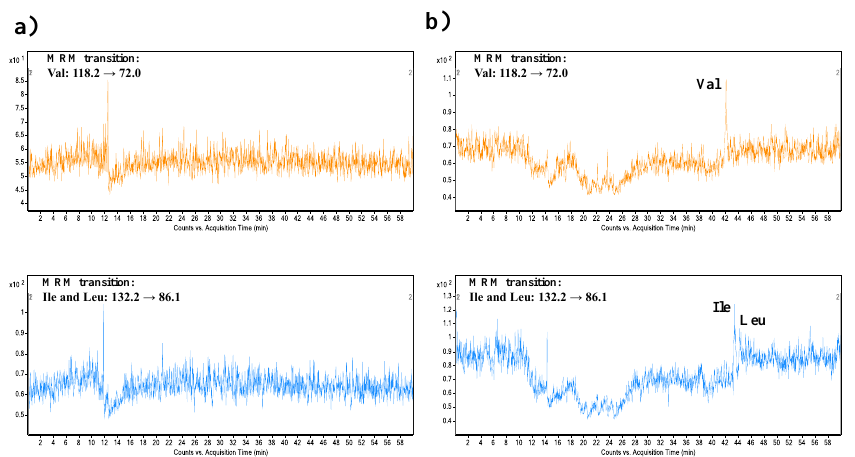
Figure 4. Extracted MRM records of Val (upper trace) and Ile and Leu (lower trace), obtained from the carryover experiment. ( a ) Analysis of BCAAs in blank sample injected after the analysis of plasma QC sample at medium concentration level (100 µM). ( b ) Analysis of BCAAs in blank sample injected after the analysis of plasma QC sample at high concentration level (300 µM). For details of the capillary electrophoresis-tandem mass spectrometry method, see Section 3.